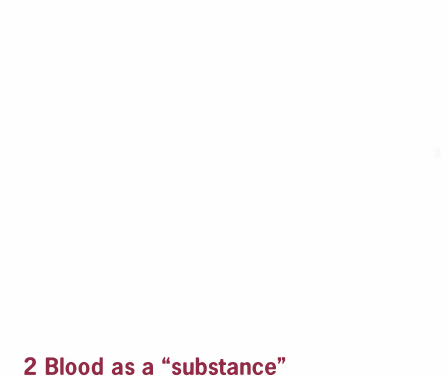
Fig. 1: Effect of aggregation and deformation of erythro- lytes on the relative apparent viscosity blood= - , erythrocytes in albumin Ringer solution = --, hardened